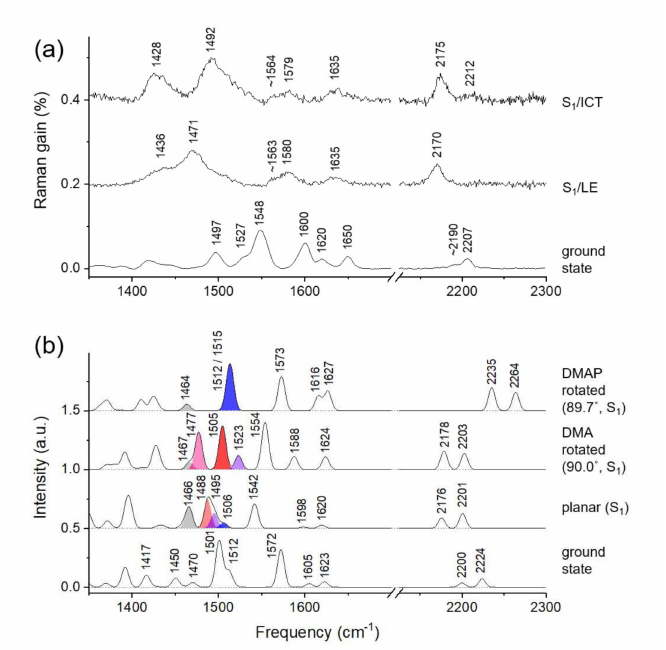
Figure 5. The Raman spectra of DCM in the ground state and the S 1 / LE and S 1 / ICT excited states; ( a ) the experimental results, ( b ) the TDDFT simulation results at B3LYP / 6-311G(d,p) level for the optimized structures in the ground and S 1 excited states. The spectral changes expected for ν 19a , ν 19b , or δ CH3 modes were displayed with